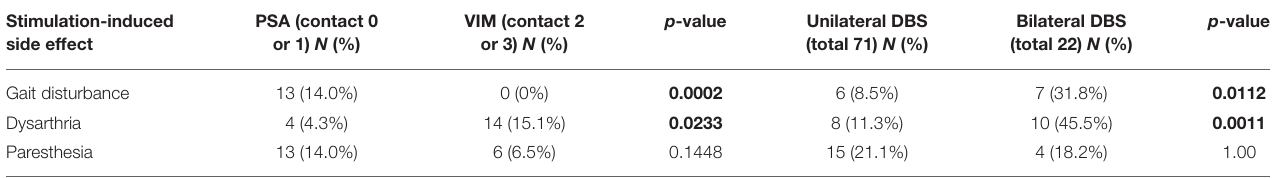
TABLE 5 | Stimulation-induced side effects on each contact.